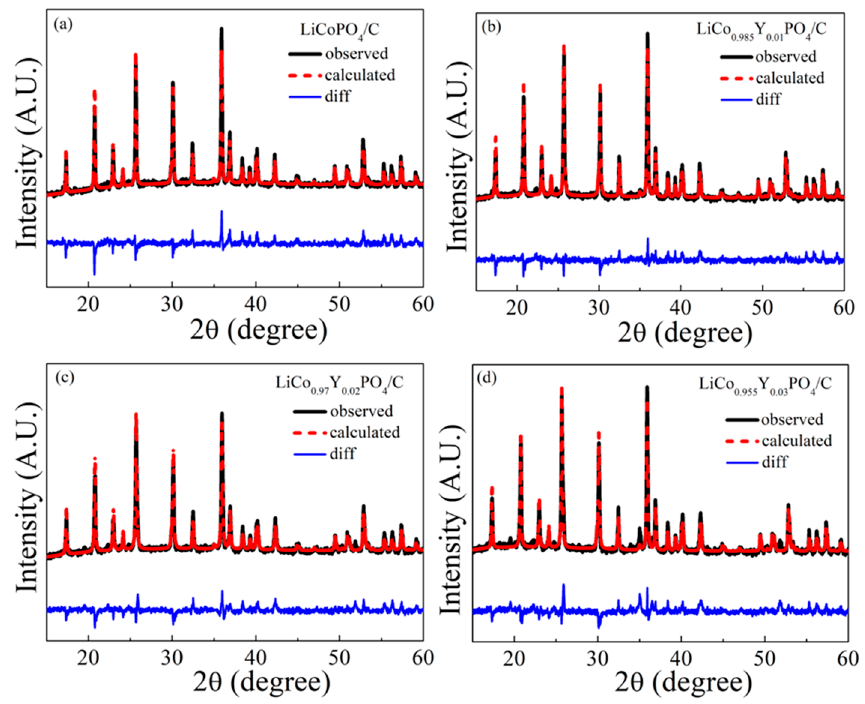
Figure 2. Refinement results of the four cathode materials. Table 1. Crystal structural parameters of the four cathode materials.